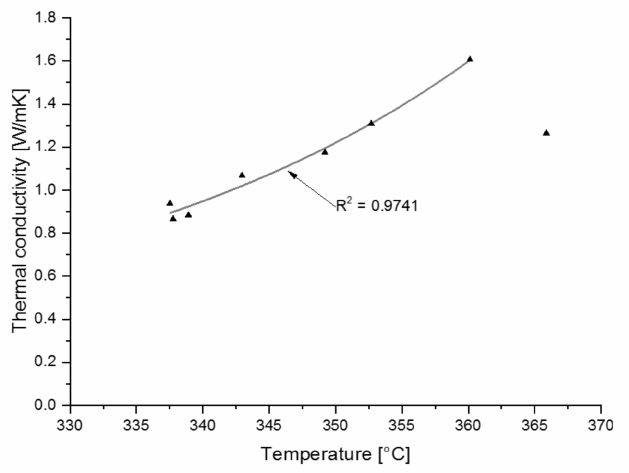
Figure 7. Effective thermal conductivity over temperature recorded in situ with a thermocell, at high temperatures in H 2 atmosphere.